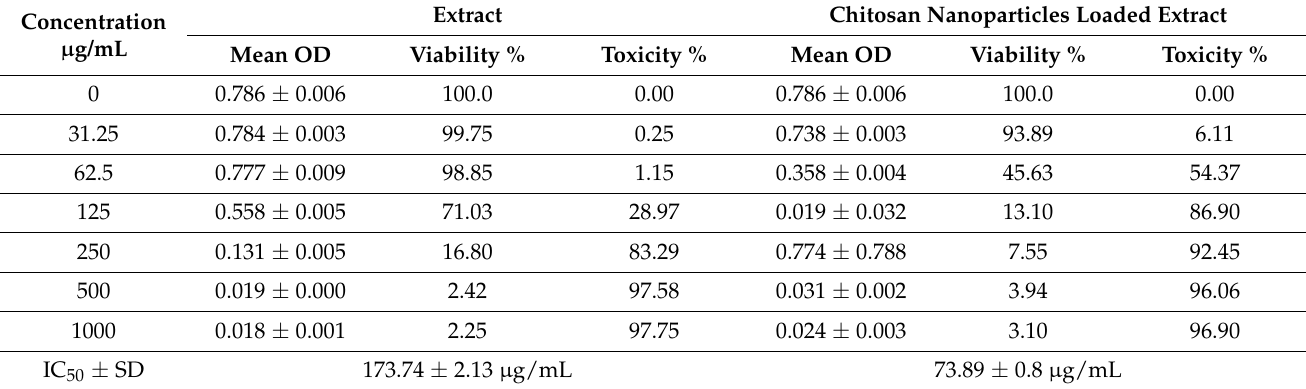
Table 3. Cytotoxicity of different concentrations of Artemisia judaica extract and chitosan nanoparticles loaded extract against normal Vero cells.